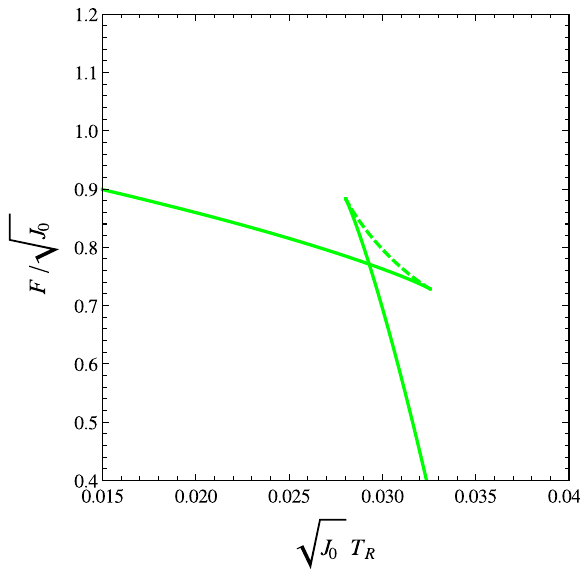
Fig. 13 Close up figure of the free energy of a Kerr black hole in the Rényi model for λ J 0 = 0 . 01 on Fig. 12. The intermediate, unstable branch is displayed with a dashed